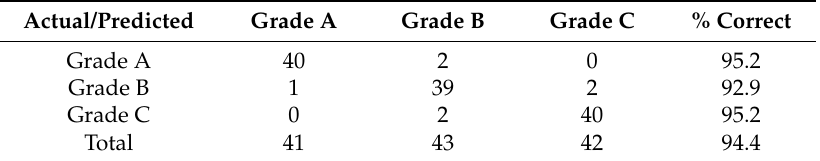
Figure 14. Plot of Harumanis mango’s mass and estimated volume. Table 8. Confusion matrix of mango grading in the proposed on-line system. The misshapen mangoes were removed from the size grading process. The regular mangoes were graded cording to pre-defined